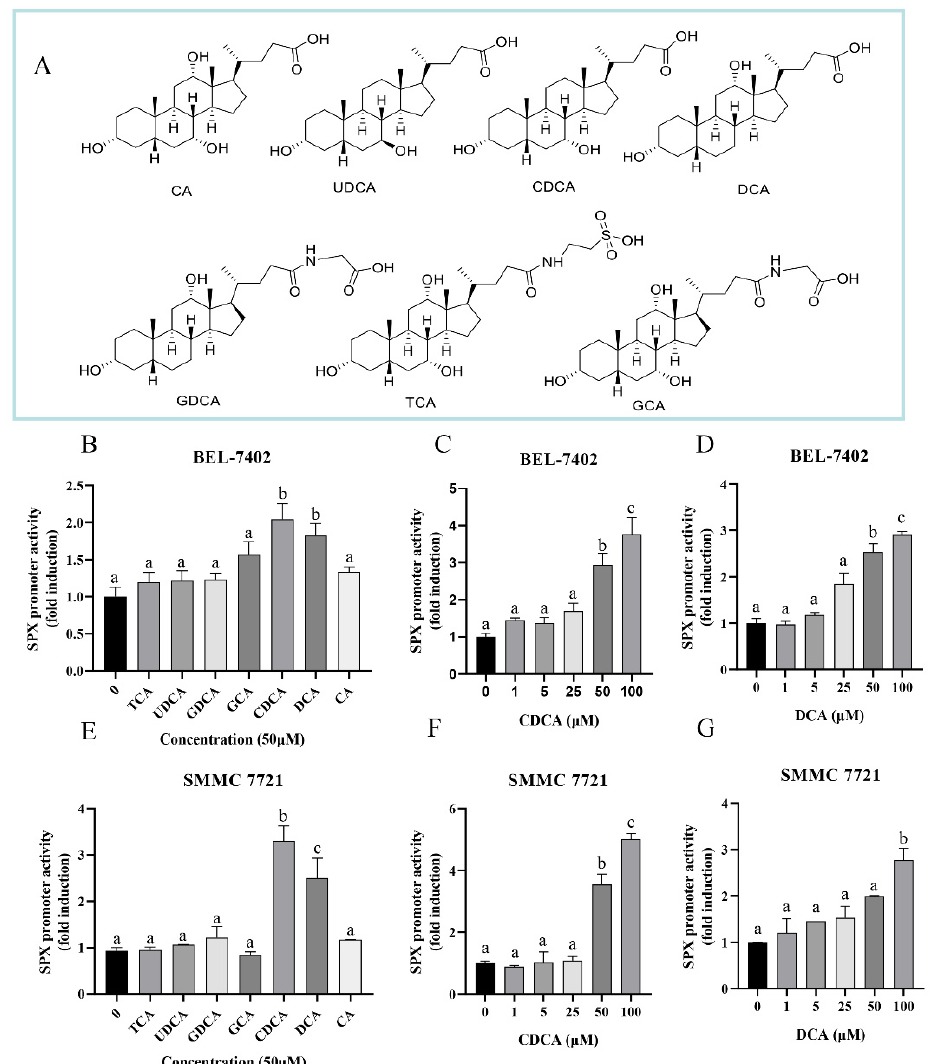
Figure 1. Effects of bile acid on SPX promoter activity were measured in SMMC7721 and BEL-7402 cells. ( A ) Chemical structure of 7 bile acids (TCA, UDCA, GDCA, GCA, CDCA, DCA and CA). ( B ) Effects of different bile acid (50 μ M, 24 h) administration on SPX Promoter in BEL-7402 cells. ( C ) Concentration gradient analysis on the effect of CDCA (1–100 μ M, 24 h) on SPX promoter activity in BEL-7402 cells. ( D ) Concentration gradient analysis on the effect of DCA (1–100 µ M, 24 h) on SPX promoter activity in BEL-7402 cells. ( E ) Effects of different bile acid (50 µ M, 24 h) administration on SPX Promoter in SMMC7721 cells. ( F ) Concentration gradient analysis on the effect of CDCA (1–100 µ M, 24 h) on SPX promoter activity in SMMC7721. ( G ) Concentration gradient analysis